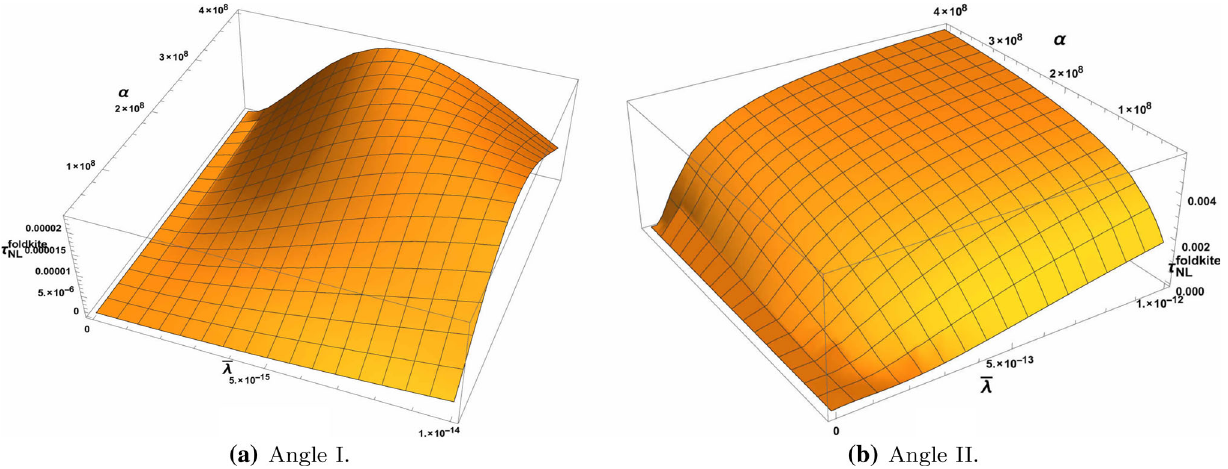
Fig. 26 Representative diagram for equilateral non-Gaussian three point amplitude vs. product of the parameters α ¯ λ in four different regions for = 50 ( red ), N = 60 ( blue ) and N = 70 ( green ) N cmb cmb cmb